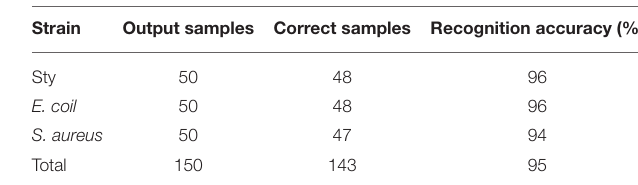
TABLE 6 | Classification results (alkaline